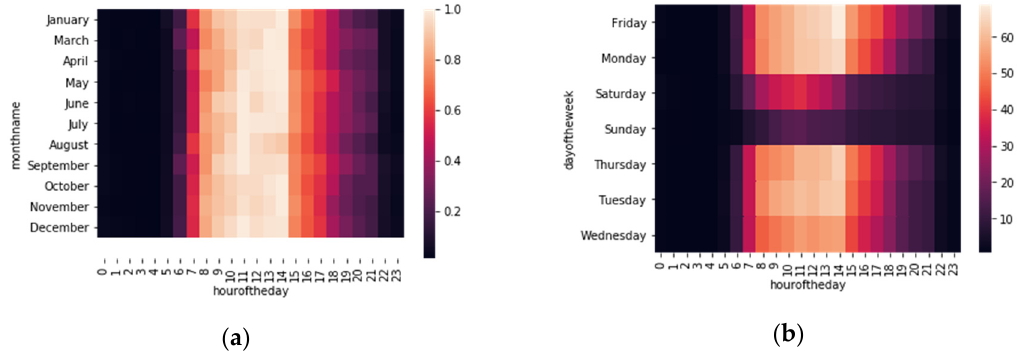
Figure A3. Heatmap of traffic at port gates. ( a ) Per month; ( b ) Per day of the week.